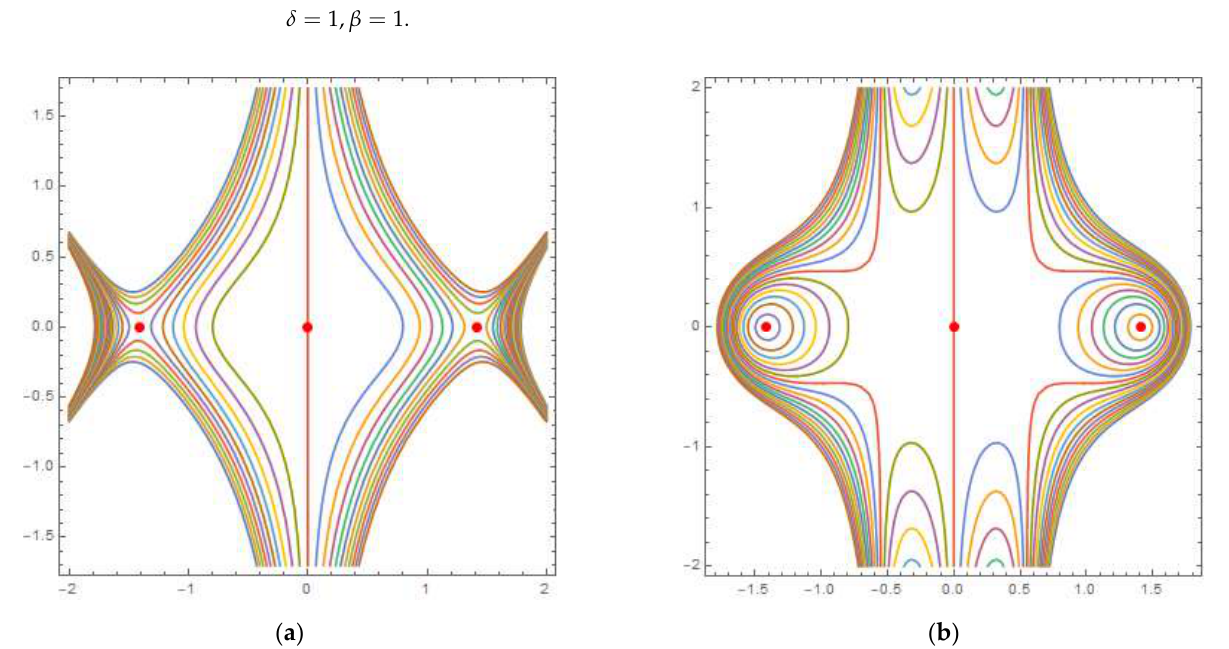
= 1, 𝑞 = 1 2 = 1, 𝑎 = 0, 𝑎 = 0, 𝑞 = 1, 𝑞 = 1, 𝑞 = −1, 𝛾 = 1, 𝛿 = 1 2 4 1 2 3